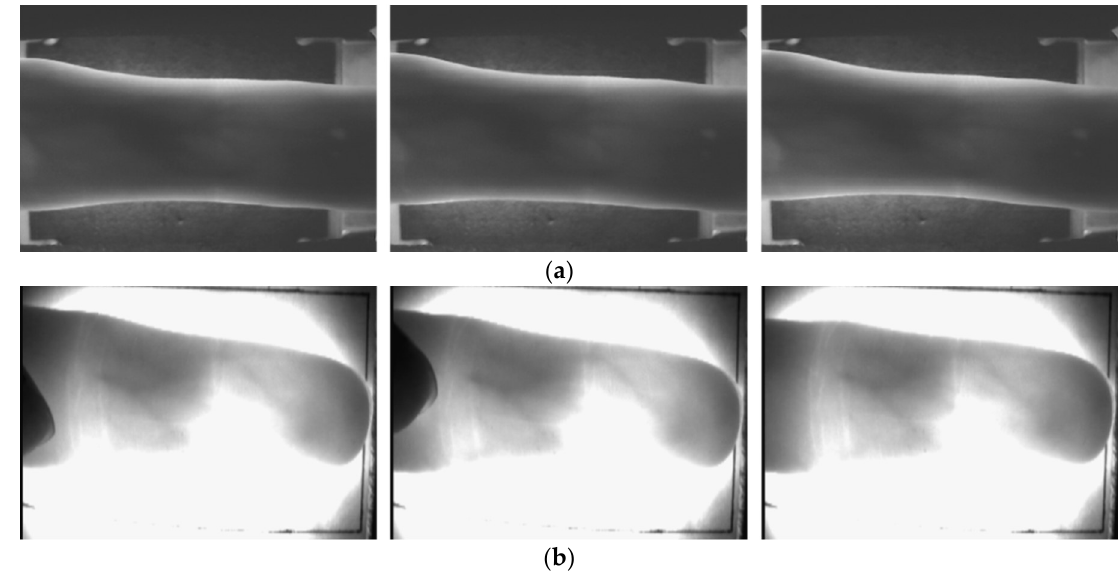
Figure 7. Examples of input images of different trials from the same finger of one individual from each database: ( a ) SDU-DB; ( b ) PolyU-DB.